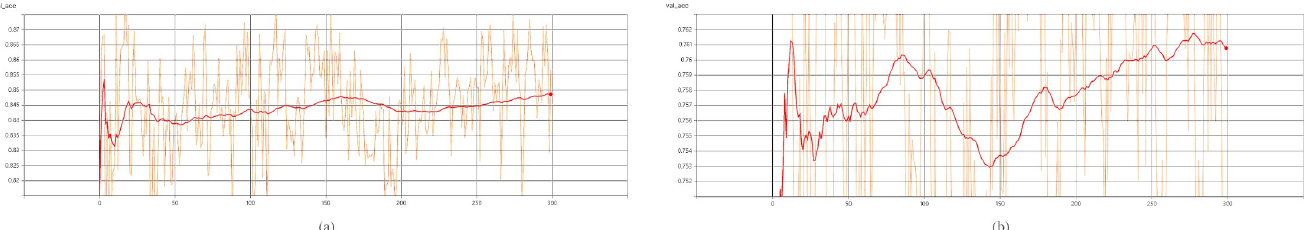
Fig 6. Loss during ResNet-50 training process for Electronic Tools Design Award dataset. (Fig (a): Nominees classification accuracy; Fig (b): Eliminated classification accuracy).